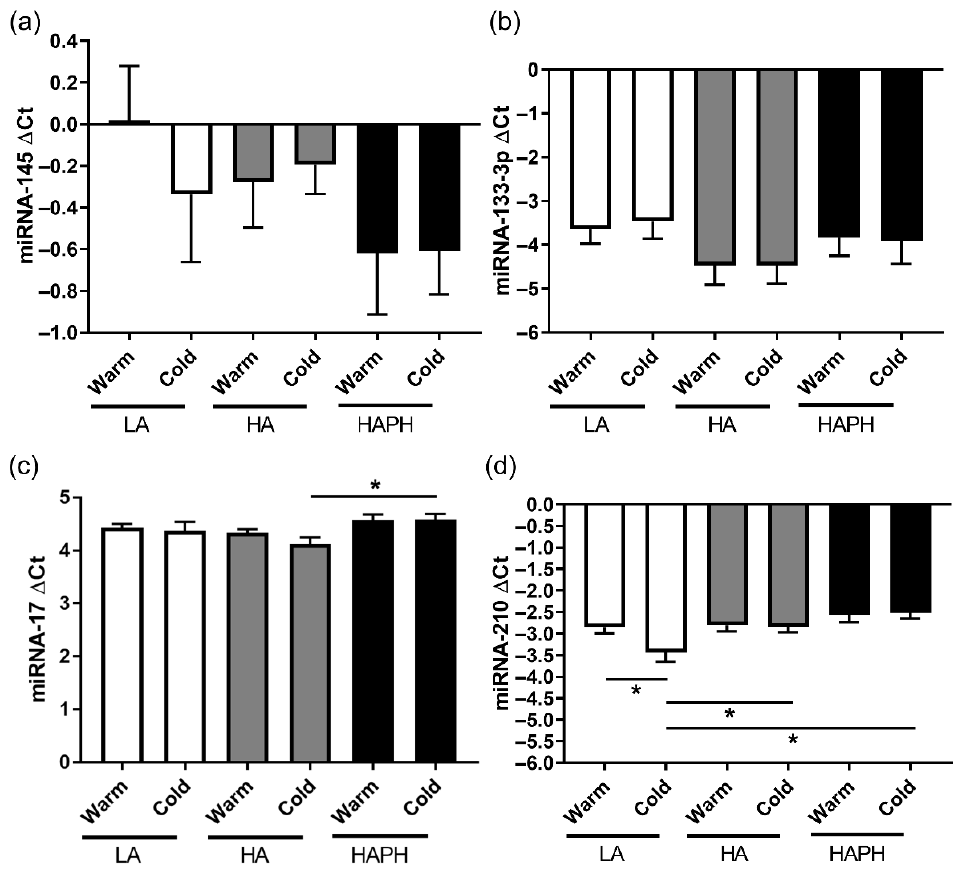
Figure 5. Effects of high altitude and cold on the content of different micro RNAs (miRNAs) in isolated microparticles (MPs). The characterization and quantification of different miRNAs in isolated MPs are performed by PCR and presented ( a – d ). LA — lowlanders, HA — highlanders, HAPH — highlanders with pulmonary hypertension. Results are presented as mean ± SEM (n = 11 – 12). * p < 0.05 values are considered statistically significant.